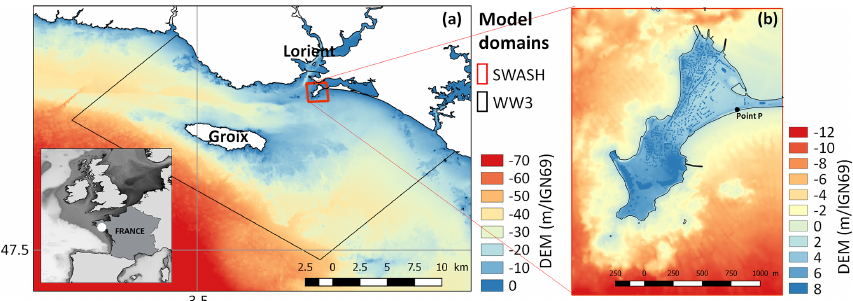
Figure 1. Digital elevation model (DEM expressed with respect to IGN69, French national vertical datum) and computational domain of the study site of Gâvres for the spectral wave model WW3 (a) and for the non-hydrostatic phase-resolving model SWASH (b) . The insert in (a) provides the regional setting. The point P indicates an observation point on the coast. Adapted from Idier et al. (2020a).